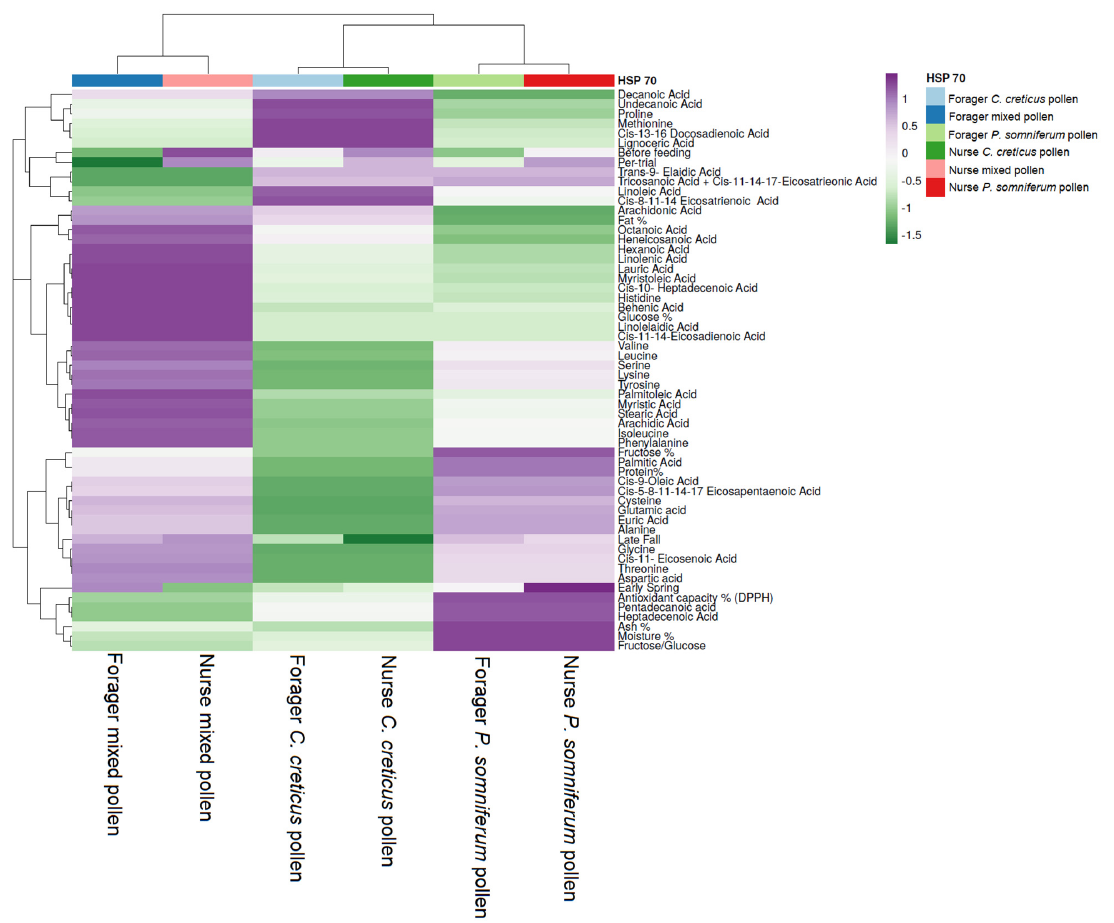
Figure 6. Hierarchical clustering and heatmap visualization of the HSP 70 protein content present in forager and nurse bees based on feeding product types’ fatty and amino acid profiles. Columns indicate the product types fed to foragers and nurse bees and rows the products’ fatty acid and amino acid patterns along with the content in HSP 70 in different periods. Cells are colored based on the quantity of HSP 70 in each forager and nurse bees, where purple represents a strong positive correlation and green a strongly negative correlation. The row dendrogram resulted from the correlation between the fatty and amino acid profiles and HSP 70 level in different feeding periods; the column dendrogram represents the correlation between forager and nurse bees and feeding product types.